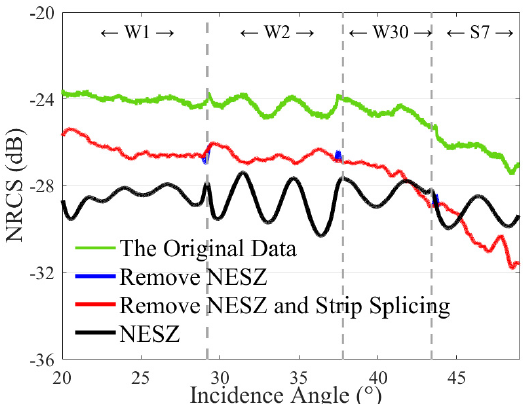
Figure 5. Influence of the reference noise on the cross-polarized NRCS. The black curve is the NESZ. The green curve is the original NRCS, while the blue curve denotes the NRCS after removing the reference noise. The red curve indicates the result after removing the NESZ and strip splicing. The vertical dashed gray lines denote the dividing lines of the four strips: W1, W2, W30, and S7.